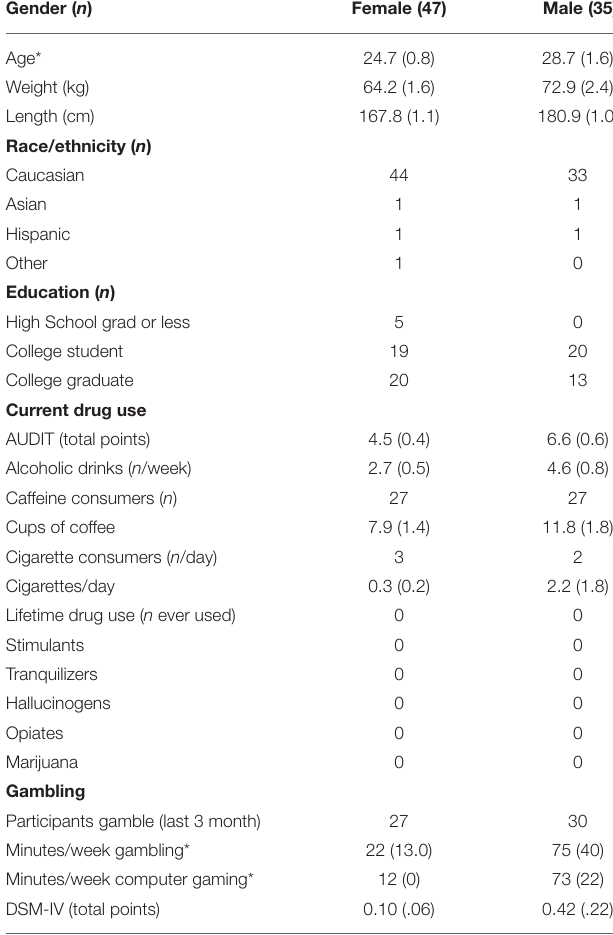
TABLE 1 | Demographics and drug use data between men and